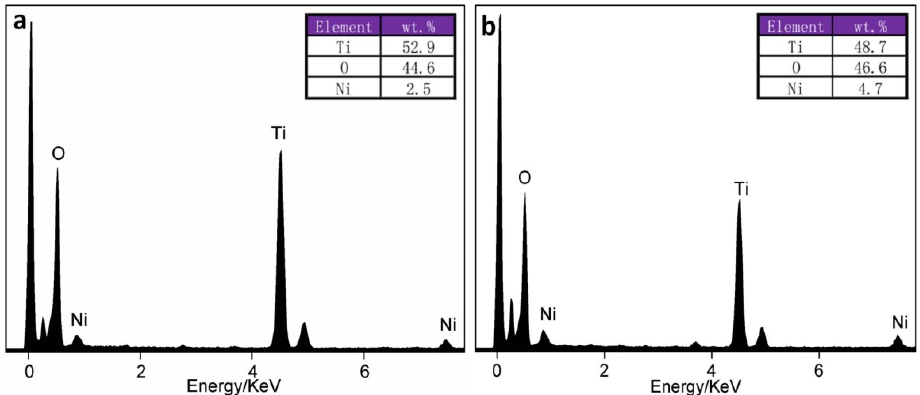
Figure 9. Energy ‐ dispersive X ‐ ray detector (EDS) point analyses of ( a ) 3 wt.% Ni ‐ doped TiO 2 Figure 9. Energy-dispersive X-ray detector (EDS) point analyses of ( a ) 3 wt.% Ni-doped TiO 2 nanofibers nanofibers and ( b ) 6 wt.% Ni ‐ doped TiO 2 nanofibers. and ( b ) 6 wt.% Ni-doped TiO 2